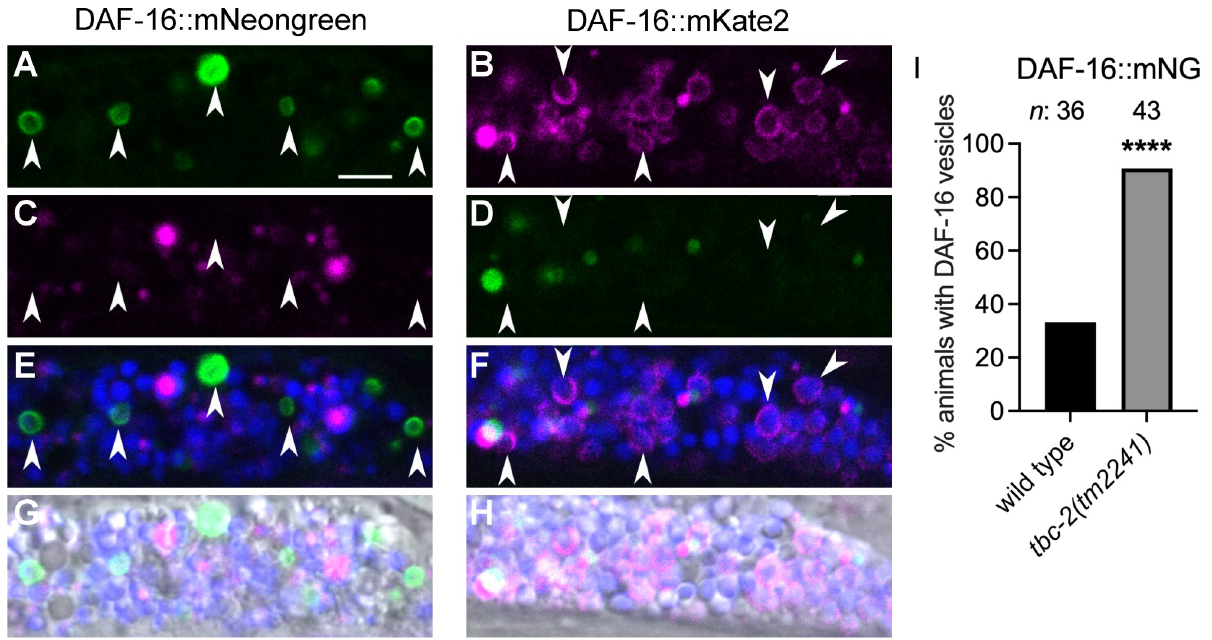
Fig 2. Endogenously tagged DAF-16::mNeongreen and DAF-16::mKate2 localize to vesicles. Representative confocal and differential interference contrast (DIC) images of intestinal cells of daf-16(ot853[daf-16 :: linker :: mNeongreen :: 3xFlag :: AID]) (A,C,E,G) and daf-16(ot821[daf-16 :: mKate2 :: 3xFlag]) (B,D,F,H). Arrows mark DAF-16::mNeongreen positive vesicles in the green channel (A) that are distinct from autofluorescence in the red (C) and blue channels shown as a merge (E). Arrows mark DAF-16::mKate2 positive vesicles in the red channel (B) that are distinct from autofluorescence in the green (D) and blue channels shown as a merge (F). For additional context the fluorescent channels were merged with their corresponding DIC image (G and H). Bar graphs displaying the percent wild-type and tbc-2(tm2241) animals with DAF-16::mNG positive vesicles (I). Raw data is available in S1 Data. Fisher’s exact test (graphpad.com) was used to determine the statistical difference between conditions. n , total number of animals. ���� P < 0 . 0001 . Scale bar (A), 5 μ